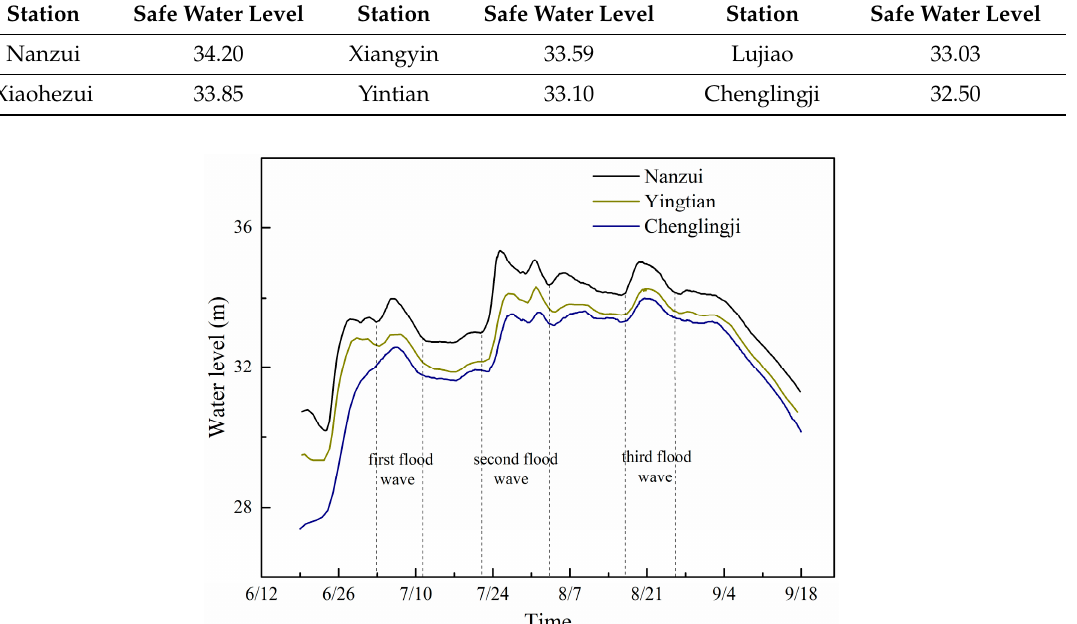
Figure 6. The flooding process in Dongting Lake at selected stations in 1998.